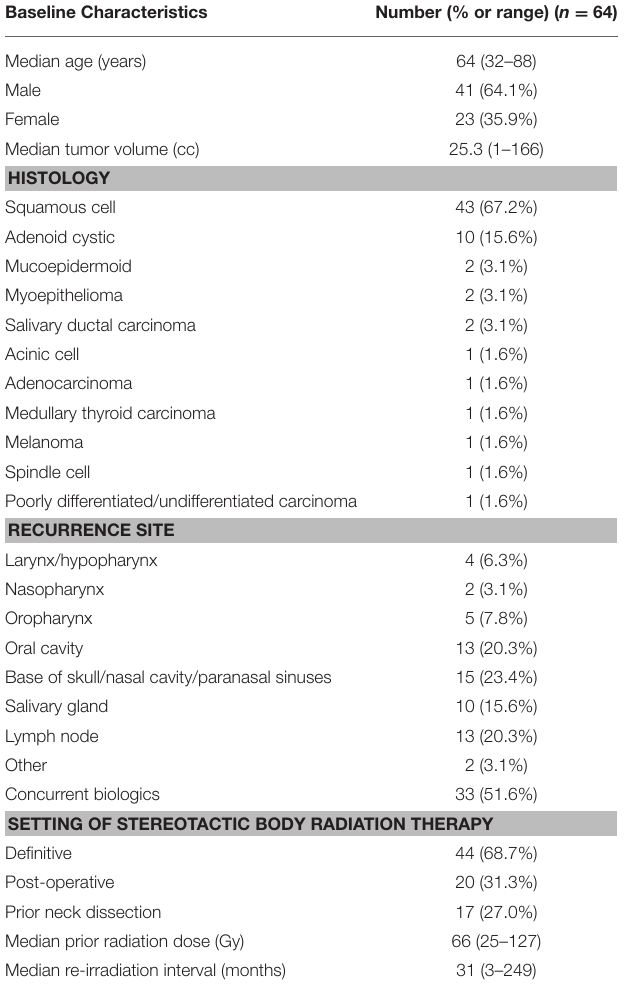
FIGURE 2 | Post-treatment average patient-reported quality-of-life scores in chewing, swallowing, speech, taste, saliva, appearance, and Physical